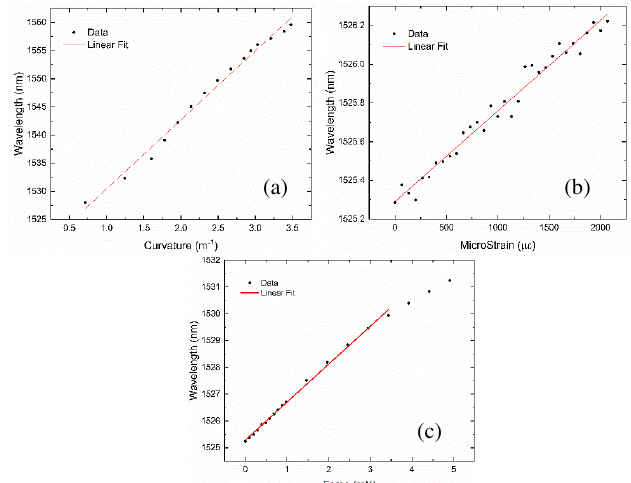
Fig. 2. Sensitivity curves of the LPG. (a) Sensitivity to curvature (0.47 pm/ με ). (b) Sensitivity to strain (12.64 nm/m -1 ). (c) Sensitivity to force (1.41 nm/mN).